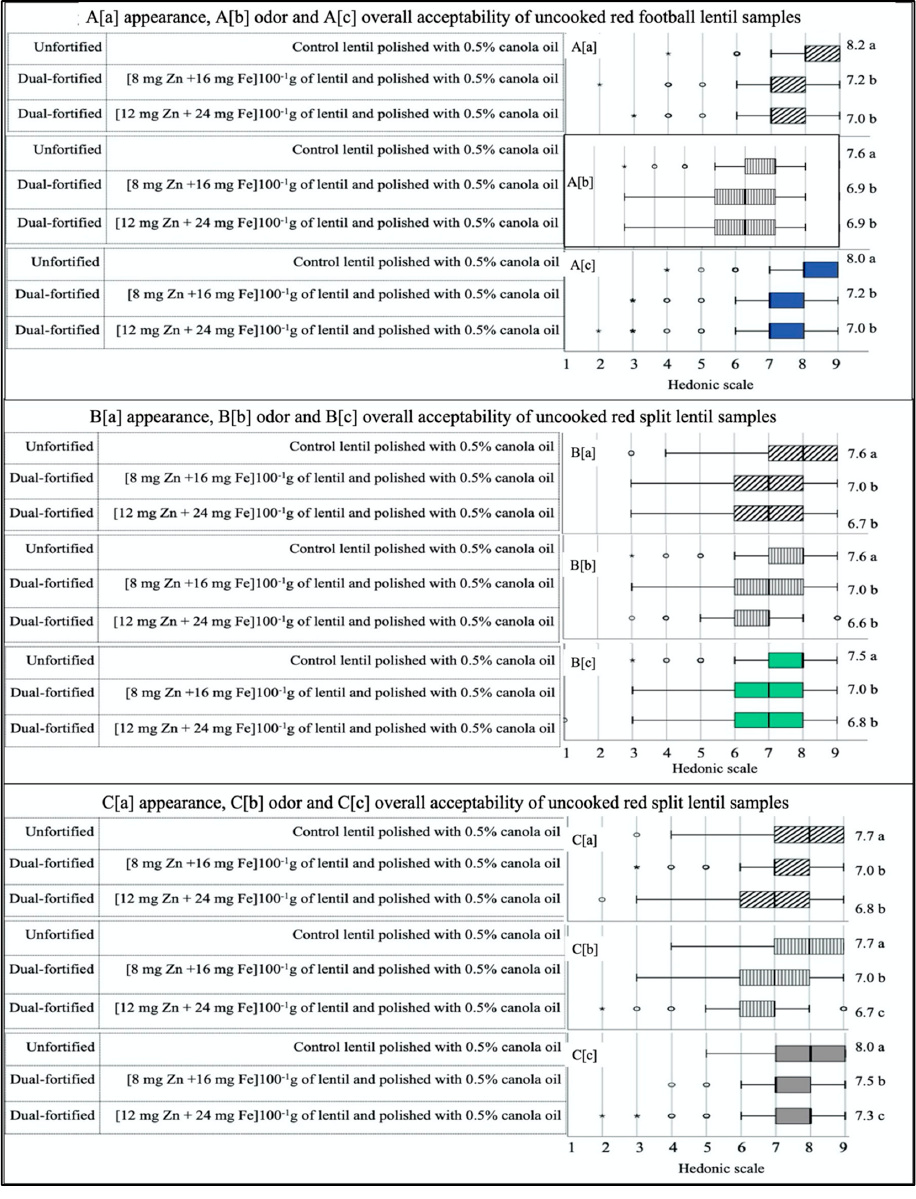
Figure 3. Box plot analysis of hedonic scores (1 = dislike extremely, 9 = like extremely) obtained for three uncooked lentil dal samples (unfortified control lentil polished with 0.5% canola oil; dual- fortified with 8 mg Zn from ZnSO 4 H 2 O +16 mg Fe from NaFeEDTA (100 − 1 g of lentils)); dual fortified with 12 mg Zn from ZnSO 4 H 2 O + 24 mg Fe from NaFeEDTA (100 − 1 g of lentils) from each of the three product types, red football ( A ), red split ( B ) and yellow split ( C ), evaluated for appearance ( A – C ( a )), odor ( A – C ( b )), and overall acceptability ( A – C ( c )), by 196 panelists in Bangladesh. Different letters after mean values in the right column indicated significant differences between three samples within each attribute. Each box plot displays the distribution of data for each sample type separately based on a five-number summary, “minimum”, first quartile (Q1), median, third quartile (Q3), and “maximum”. 3.4. Liking for the Cooked, Fortified Lentil Dal For all three LPTs, unfortified cooked control samples received the highest mean score for all five attributes (appearance, odor, taste, texture, and overall acceptability) compared to the fortified